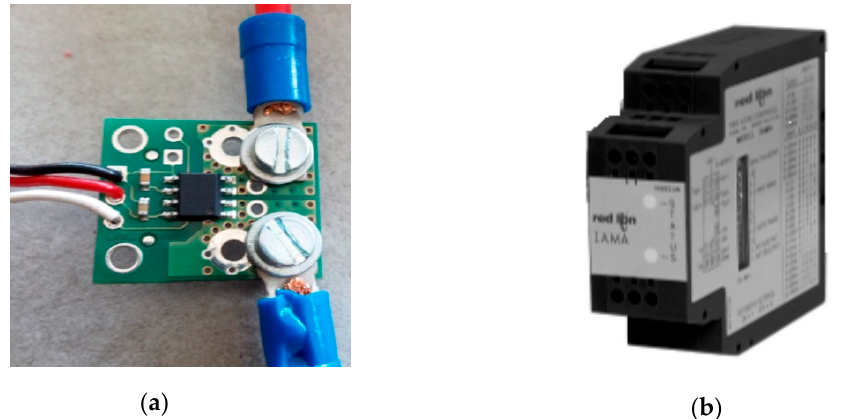
Figure 4. ( a ) Sensor to measure I A : sensor ACS714. ( b ) Sensor to measure V A : sensor IAMA3535.